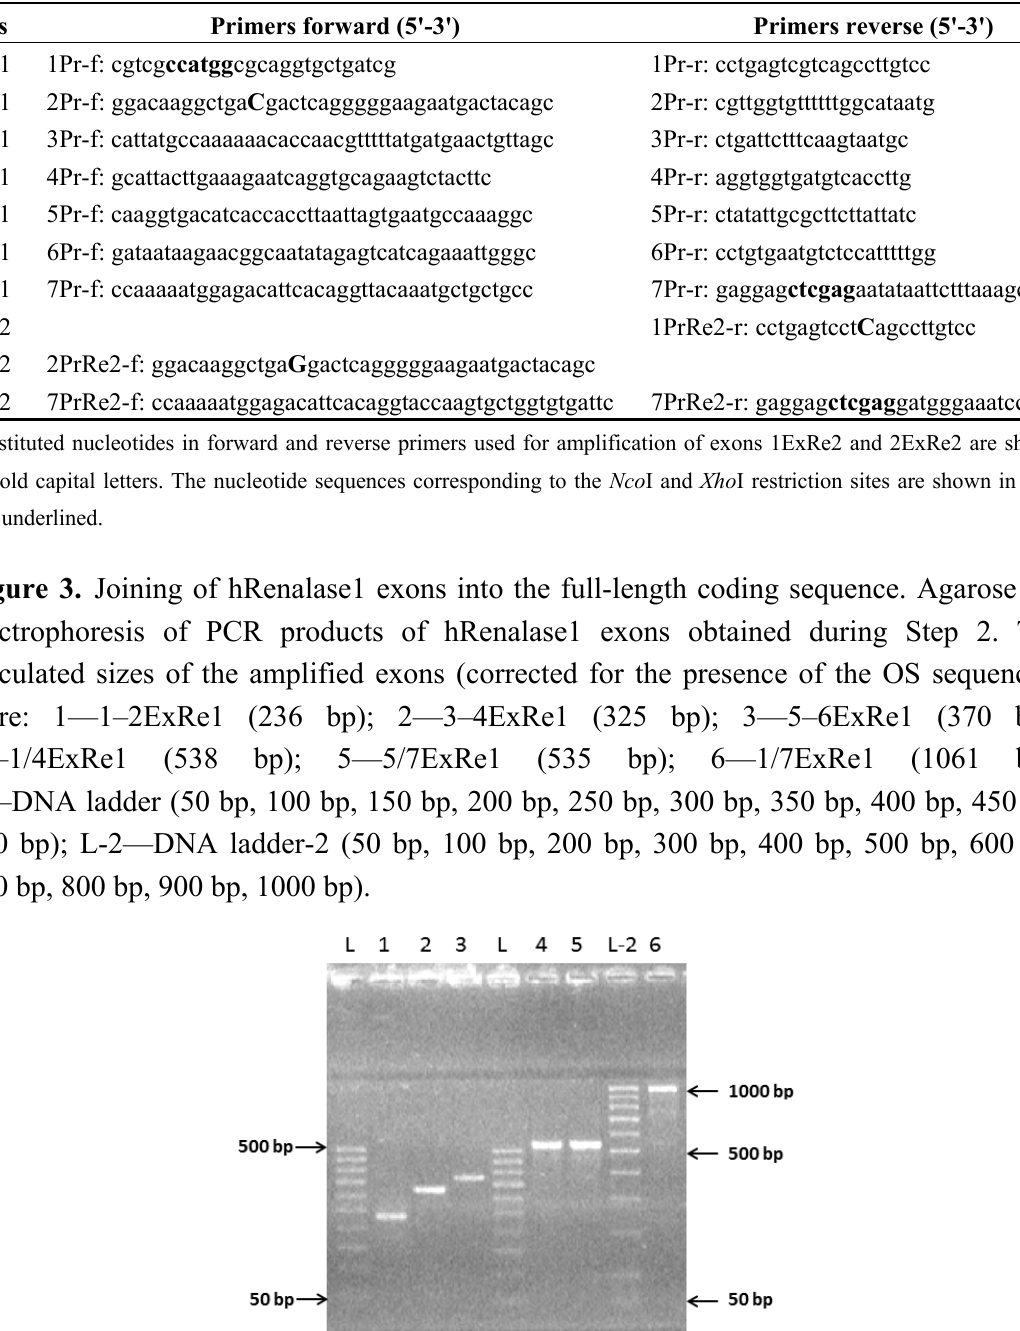
Table 1. Primers used for overlapping PCR.